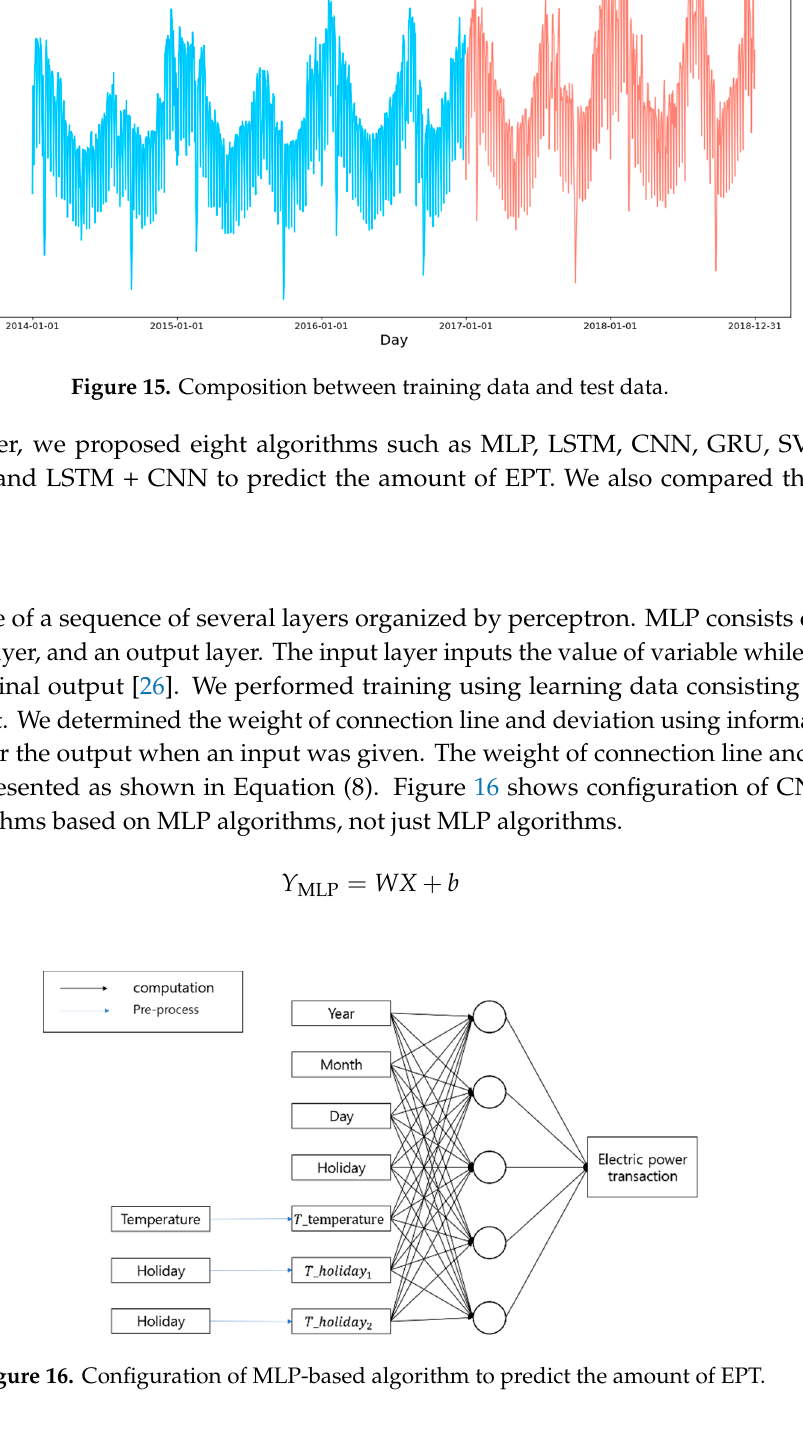
Figure 15. Composition between training data and test data.